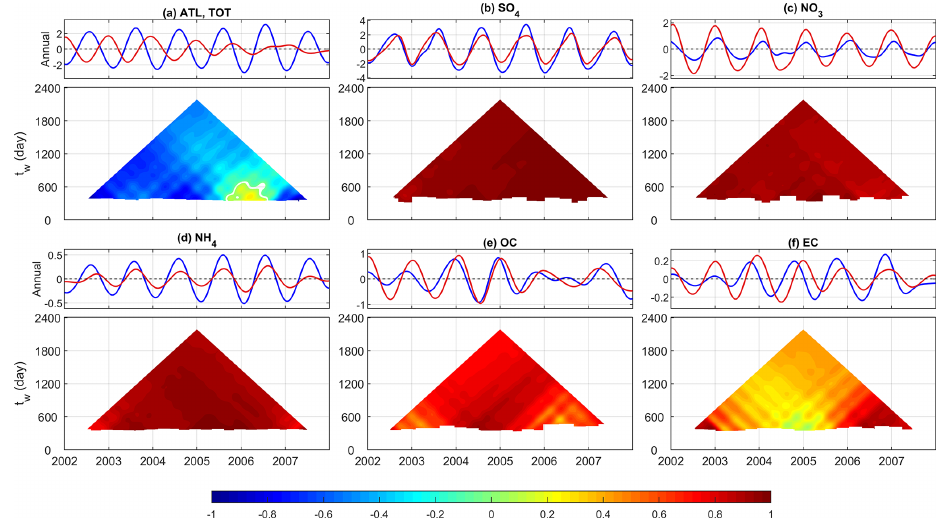
Figure 9. Same as in Fig. 7 for Atlanta, GA, except that the annual component is resolved in IMF8 (IMF7 for SO 4 and NO 3 ) because of the difference in sampling rate and characteristics embedded in the time series at ATL, and (d) represents NH 4 rather than Cl.